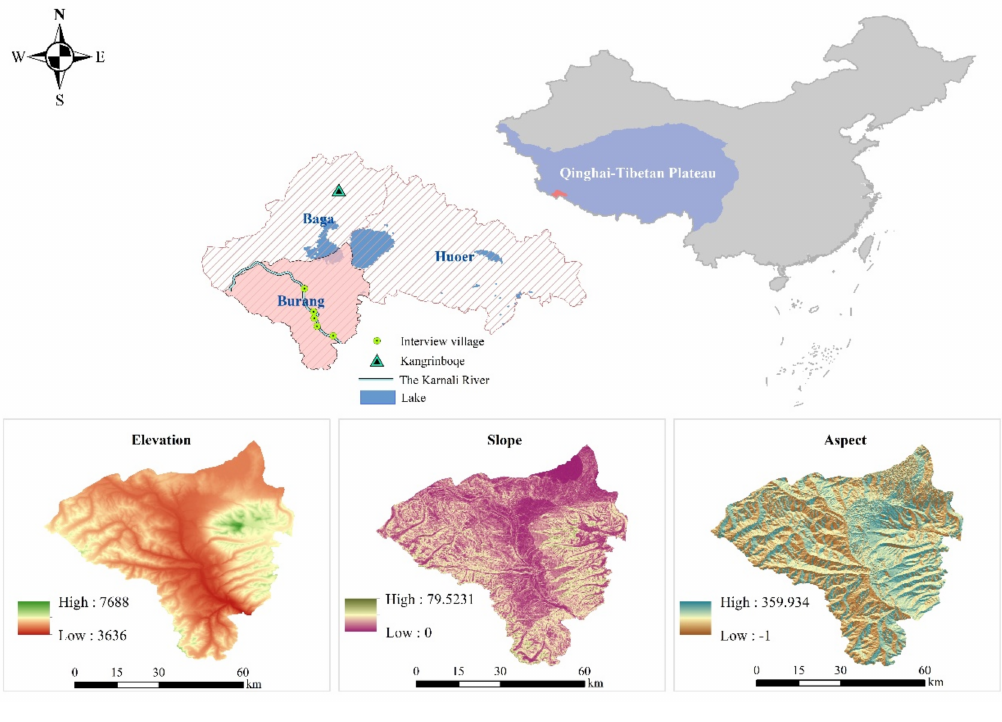
Figure 1. The study area: Burang Town, Tibet, China.